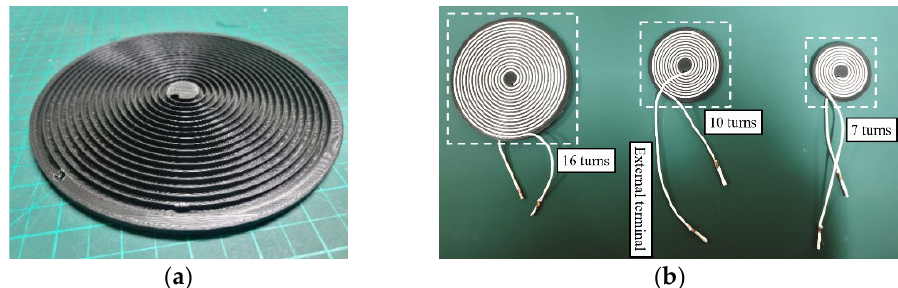
Figure 9. Spiral coil and bobbin. ( a ) Bobbin. ( b ) Spiral coil wound on the bobbins.